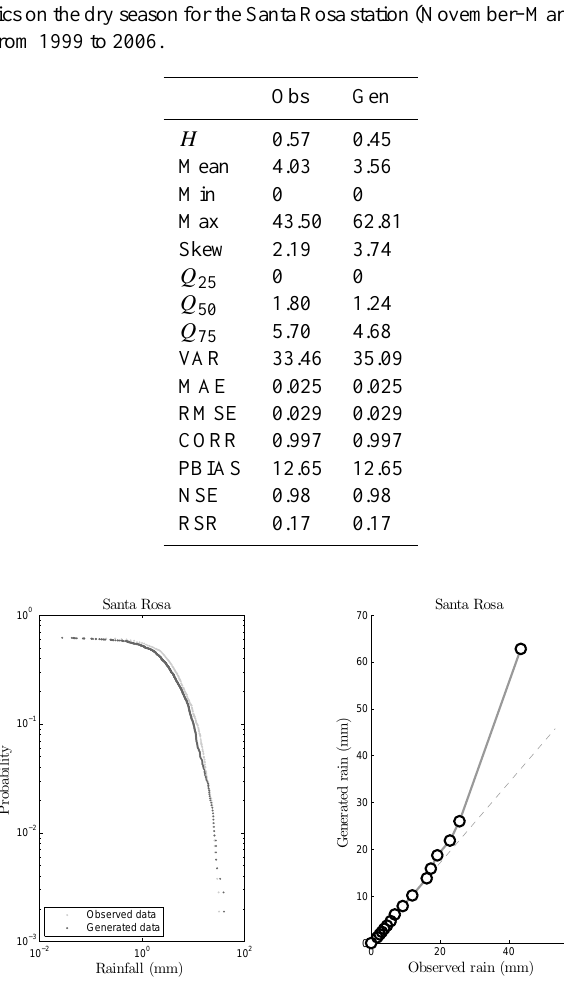
Table 6. Goodness of fit for exceedance probability curve and statis-